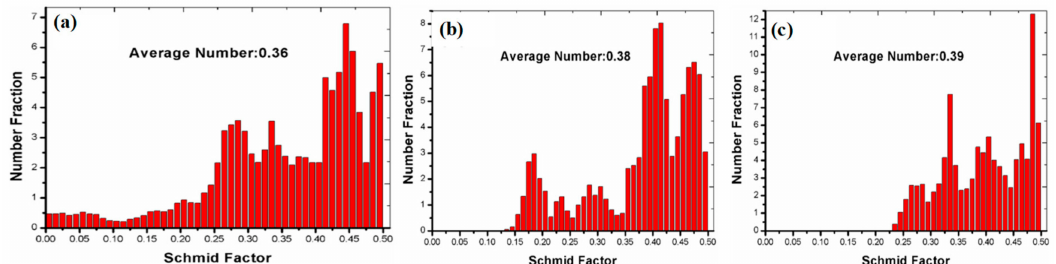
Figure 4. The magnitude of Schmid factors of the various sliding systems for the as-MAFed pure Mg: ( a ) The basal < a > sliding system ({0001} < 11–20 > ; ( b ) the pyramidal < c + a > sliding system {10–11} < 11–20 > ; and ( c ) the pyramidal < c + a > sliding system {11–22} < 11–23 > .